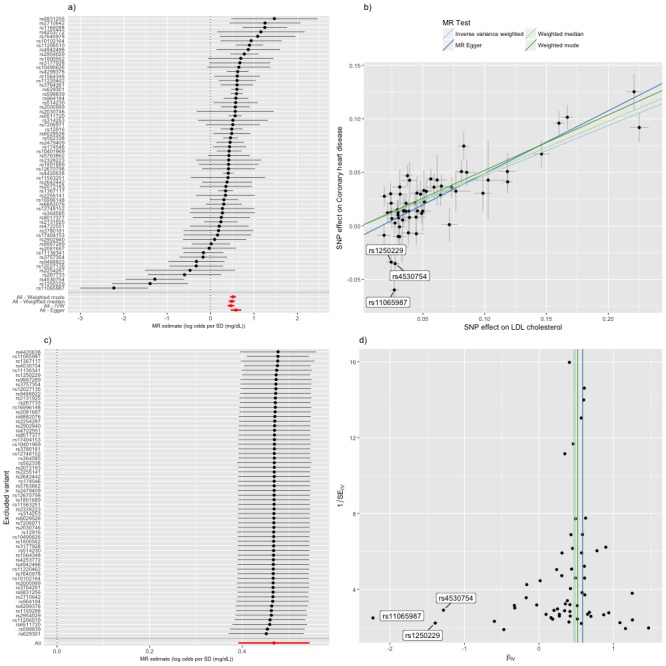
Mendelian randomization study of the effect of low density lipoprotein cholesterol levels on coronary heart disease.(a) A forest plot, where each black point represents the log odds ratio (OR) for coronary heart disease (CHD) per standard deviation (SD) increase in low density lipoprotein (LDL) cholesterol, produced using each of the ‘LDL single nucleotide polymorphisms (SNPs)’ as separate instruments, and red points showing the combined causal estimate using all SNPs together in a single instrument, using each of four different methods (weighted median, weighted mode, inverse-variance weighted [IVW] random effects and MR-Egger). Horizontal lines denote 95% confidence intervals. (b) A plot relating the effect sizes of the SNP-LDL association (x-axis, SD units) and the SNP-CHD associations (y-axis, log OR) with standard error bars. The slopes of the lines correspond to causal estimates using each of the four different methods. Outlier SNPs are labeled. (c) Leave-one-out sensitivity analysis. Each black point represents the IVW MR method applied to estimate the causal effect of LDL on CHD excluding that particular variant from the analysis. The red point depicts the IVW estimate using all SNPs. There are no instances where the exclusion of one particular SNP leads to dramatic changes in the overall result. (d) Funnel plot showing the relationship between the causal effect of LDL on CHD estimated using each individual SNP as a separate instrument against the inverse of the standard error of the causal estimate. Vertical lines show the causal estimates using all SNPs combined into a single instrument for each of four different methods. There is some asymmetry in the plot (an excess of strong protective effects associated with higher LDL cholesterol), which is potentially indicative of violations of instrumental variable (IV) assumptions, e.g. violation of the IV2 assumption through horizontal pleiotropy. Outlier SNPs are labeled.